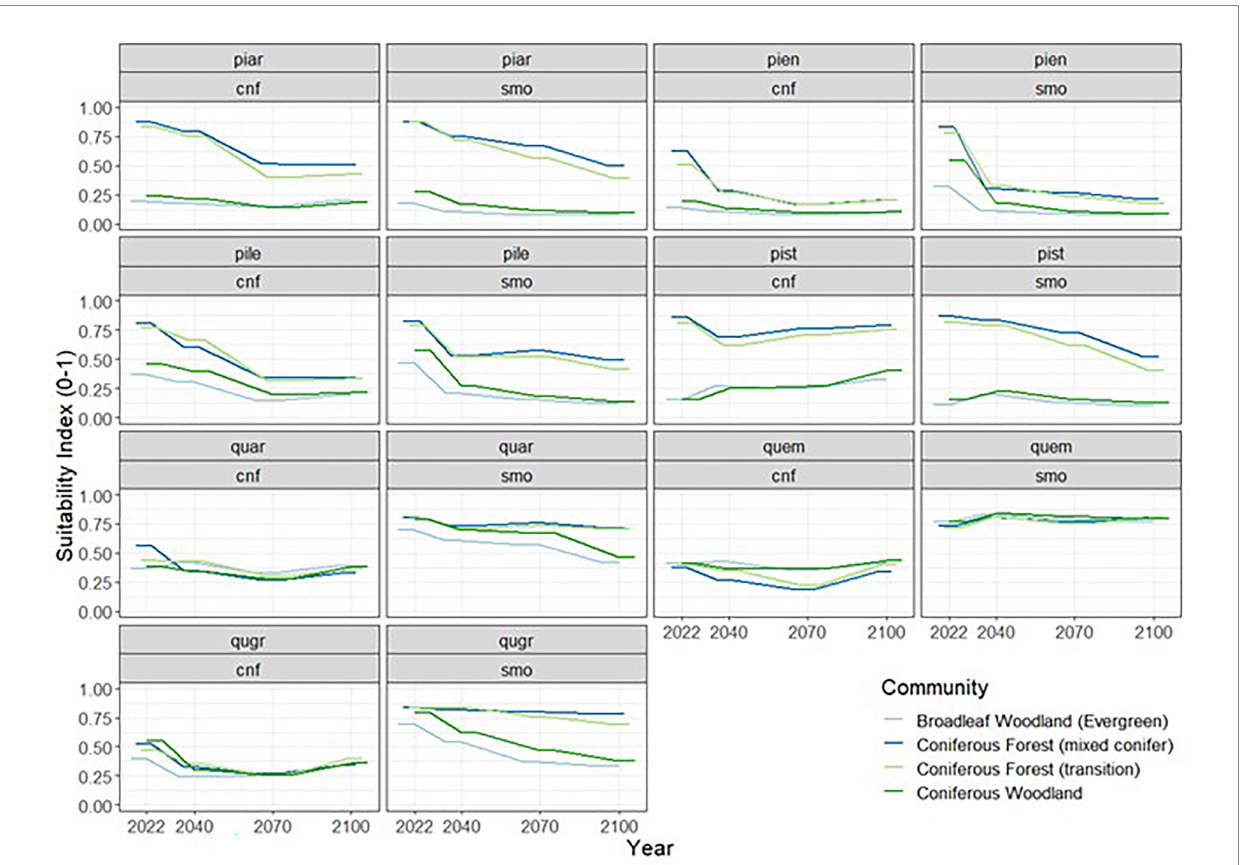
FIGURE 6 Projected change in habitat suitability of the seven tree species of interest within four common forest community boundary designations in the Coronado National Forest. Lines represent the mean estimated